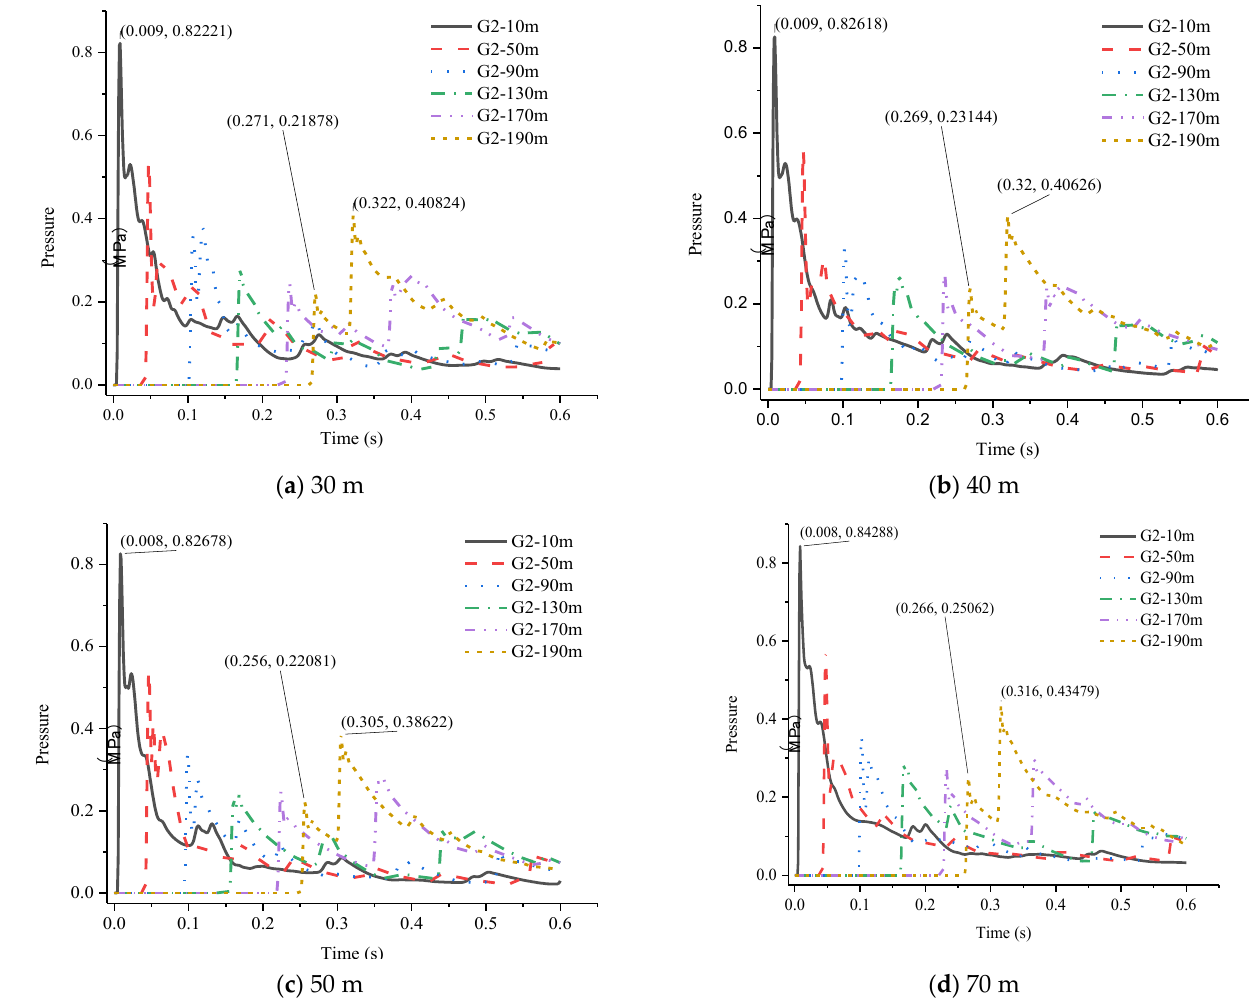
Figure 13. Overpressure- time curve of middle of gas cabin with different gas baffle spacing .